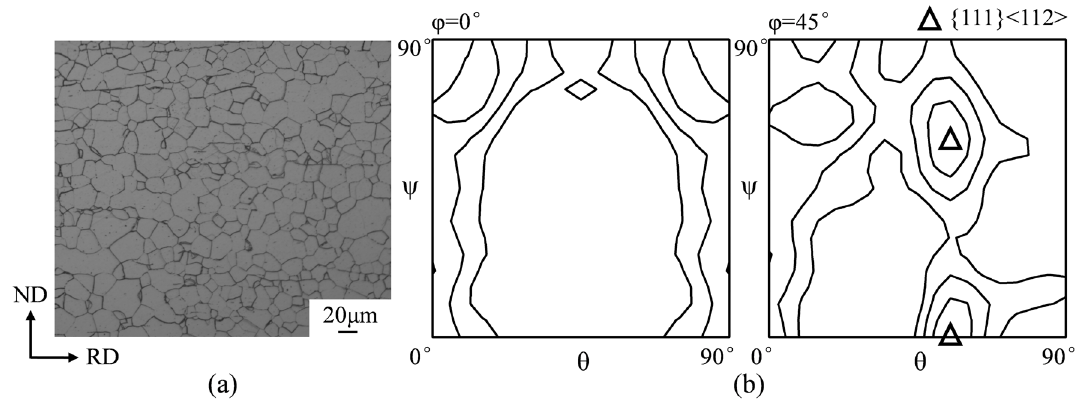
Figure 4. (a) Microstructure and (b) constant φ = 0° and 45° sections of ODFs (levels: 1, 2, 3...) in Fe-4.5 wt.% Si sheets after decarburization annealing at 830 °C for 83%